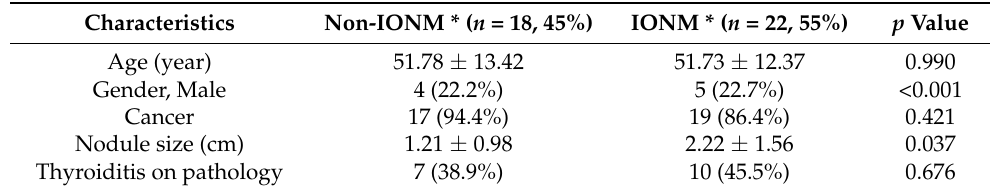
Table 1. Demographic characteristics of IONM * and non-IONM * groups.